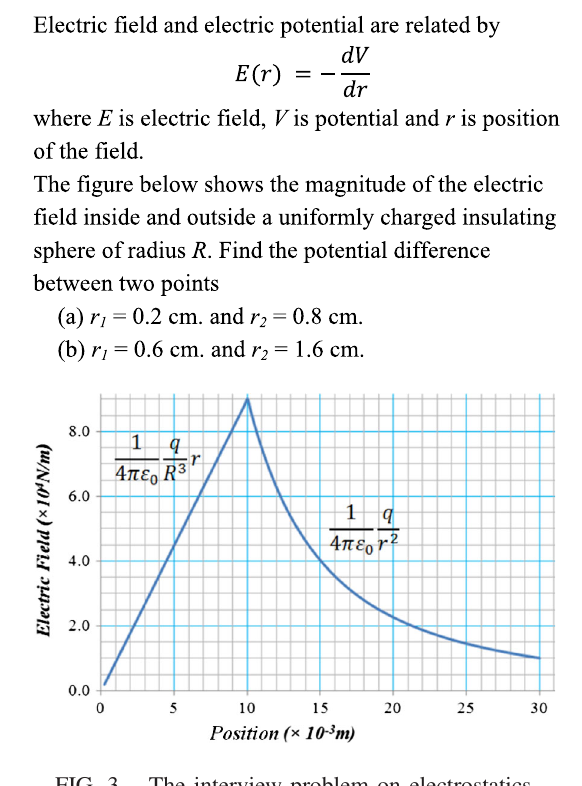
FIG. 3. The interview problem on